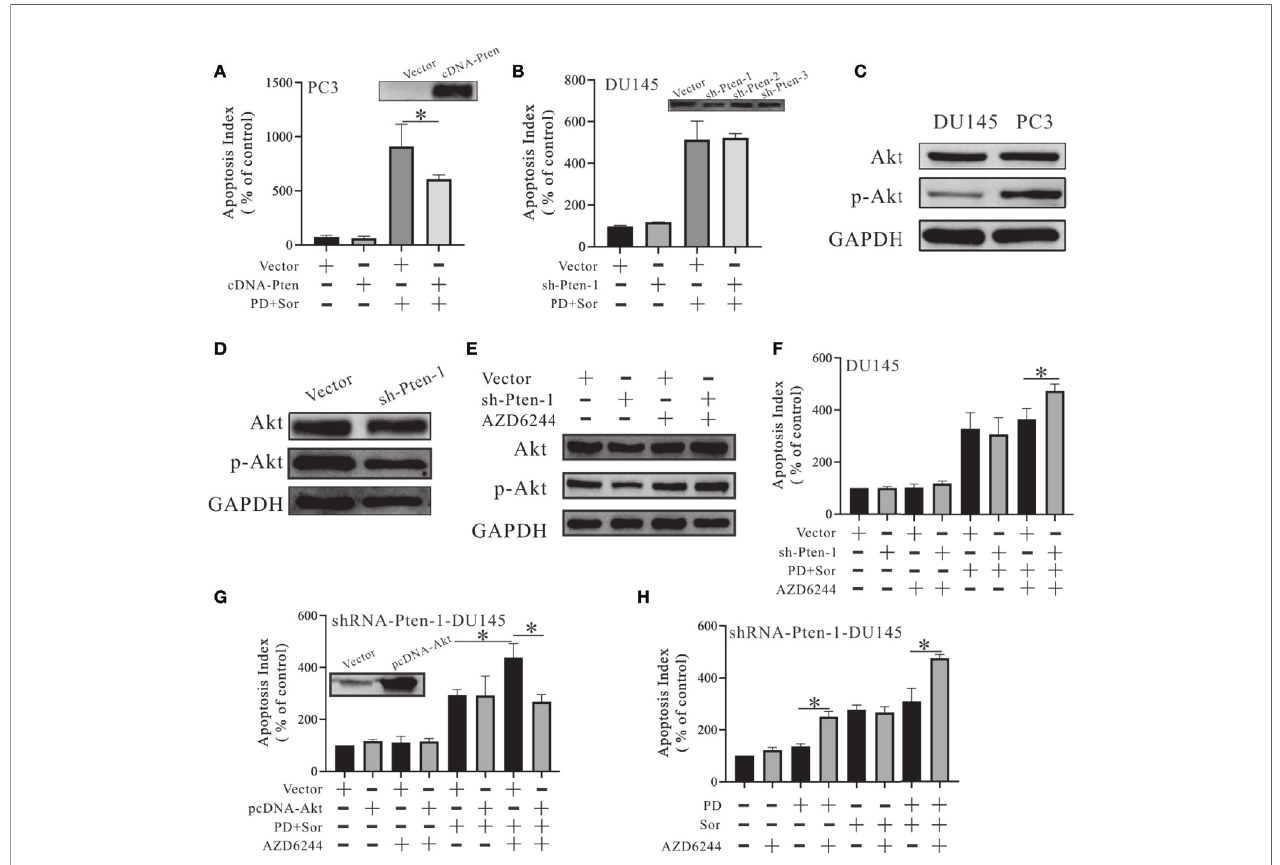
FIGURE 2 | PDpromotestheanti-tumor effectsofsorafenibinanAkt-dependentmanner inPTEN-de fi cientprostatecancer cells. (A, B) The changesinapoptosiswere monitoredbyFITC andPIdoublestaininginPC3 cellswithPTENoverexpression (A) andDU145 cellswithPTENinhibition (B) . (C) TheproteinexpressionlevelsofAktandp-Akt inDU145andPC3cells. (D) ChangesintheproteinexpressionlevelsofAktandp-AktinDU145cells withPTENinhibition. (E) Changesinthe proteinexpressionlevelsofAktand p-AktinDU145cellswithPTENinhibitionafter pre-treatmentwith50 m MAZD6244for 2h. (F) Theeffectsof10 m MPDcombinedwith10 m M sorafenibonapoptosisinshRNA- PTEN-DU145cellswithandwithoutpre-treatmentwith50 m MAZD6244for 2h. (G) ChangesintheeffectsofPDcombinedwithsorafenibonapoptosis inshRNA-PTEN-DU145 cells after pre-treatmentwithor without50 m M AZD6244for 2handwithor withoutAktoverexpression. (H) Changesintheeffectsof10 m MPD, 10 m MsorafenibandPDplus sorafenibontheapoptosisofshRNA-PTEN-DU145cells afterpre-treatmentwithor without50 m M AZD6244for 2h. * p <